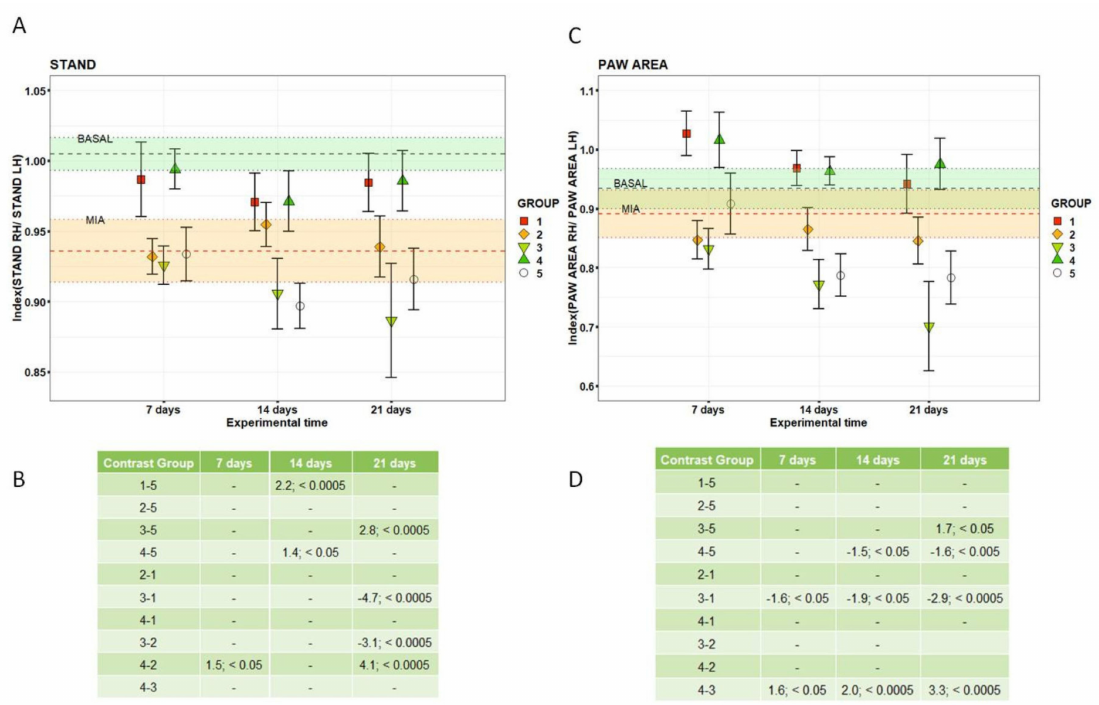
Figure 2. CatWalk results. Dot plots ( A , C ) and table reporting pairwise comparisons ( d -value; p -value) ( B , D ) of the Stand results and Paw Area for each treatment measured at each experimental time. Dots indicate mean and error bars indicate SE. Stand and Paw Area values (mean and SE) measured at baseline (BASAL) and seven days after MIA (MIA) are reported as green and orange zones. The selected LMM models showed significant interaction of treatment and experimental time factors for Stand values (F = 5.43, p < 0.0005) and Paw Area (F = 3.40, p < 0.0005). Group 1: TA; group 2: HY-CTL; group 3: RV2; group 4: RV4.5; group 5: NaCl. Right hind paw (RH) and left hind paw